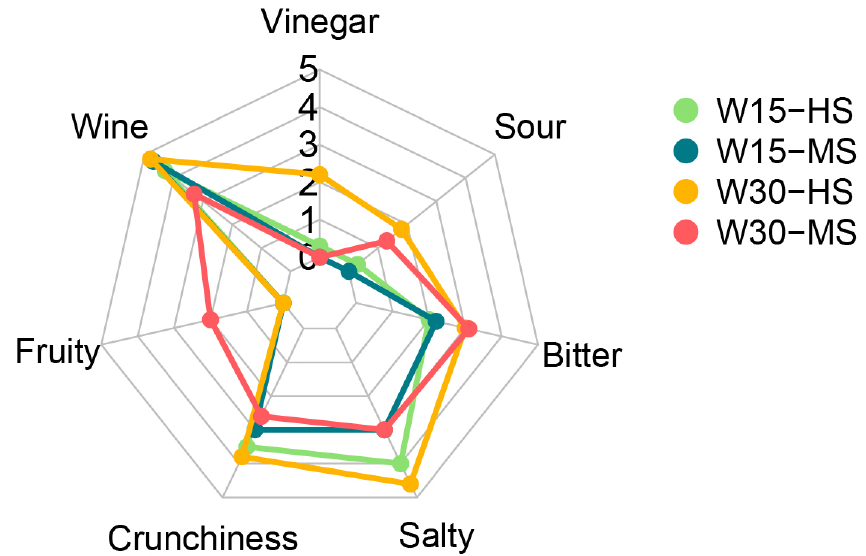
Figure 3. Sensory profile of ‘Itrana’ table olives at the end of four 165-day-long processing methods. For each treatment, the graph reports the median intensity for the different sensory attributes using a non-structured scale, starting from 0 (absence of the sensation) and ending at 10 (extremely intense). W15-HS:15 days in water and then salting with 8% NaCl brine (pea); W15-MS: 15 days in water and then salting with 6% NaCl brine (teal); W30-HS: 30 days in water and then salting with 8% NaCl brine (orange); W30-MS: 30 days in water and then salting with 6% NaCl brine (crimson). As expected, the higher salt concentration (8%) was associated with a higher “salty” score. The time of the addition of the salt had a very limited influence on the two 8% salt tration (6%). Similarly, differences in crunchiness due to salt were limited, with slightly